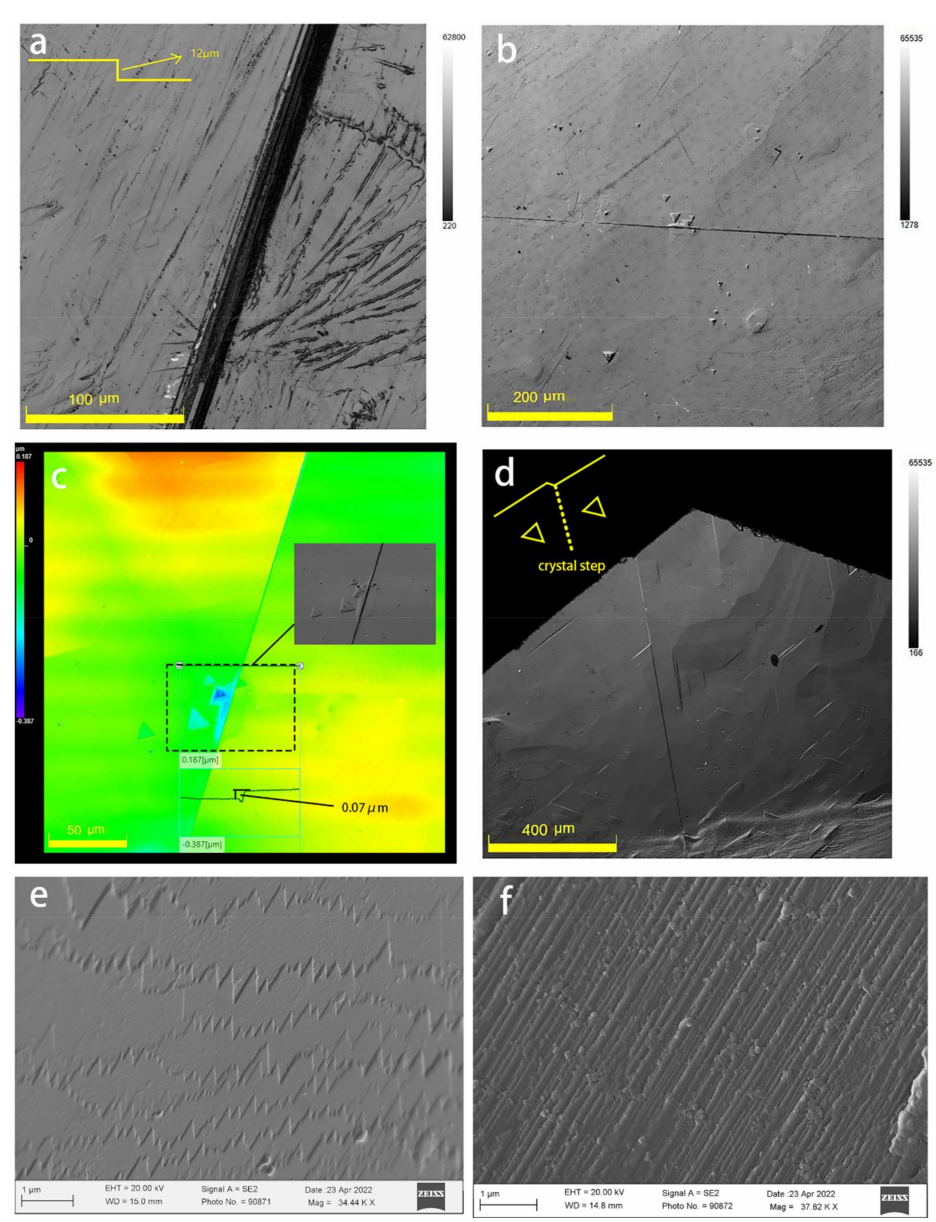
Figure 6. Growth features of HPHT synthetically grown diamonds with contact twinning: ( a ) the crystal steps accompanied by a dendritic pattern and the step height is about 12 µ m in TW-02; ( b , c ) the crystal step can penetrate the etch pits in TW-04; ( d ) the orientations of the trigon pits on both sides of the twin boundary are consistent in TW-10; ( e , f ) different growth features for (111) and (100) planes in TW-10 indicate that the substrate of the cube surface is obviously rougher than that of the